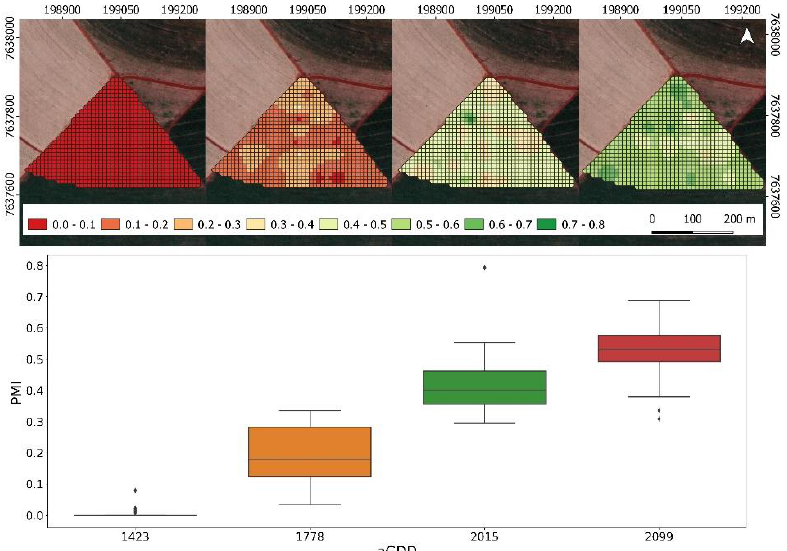
Figure 3. Spatial and temporal variability maps in the function of degree days (aGDD) and box plot distribution for peanut